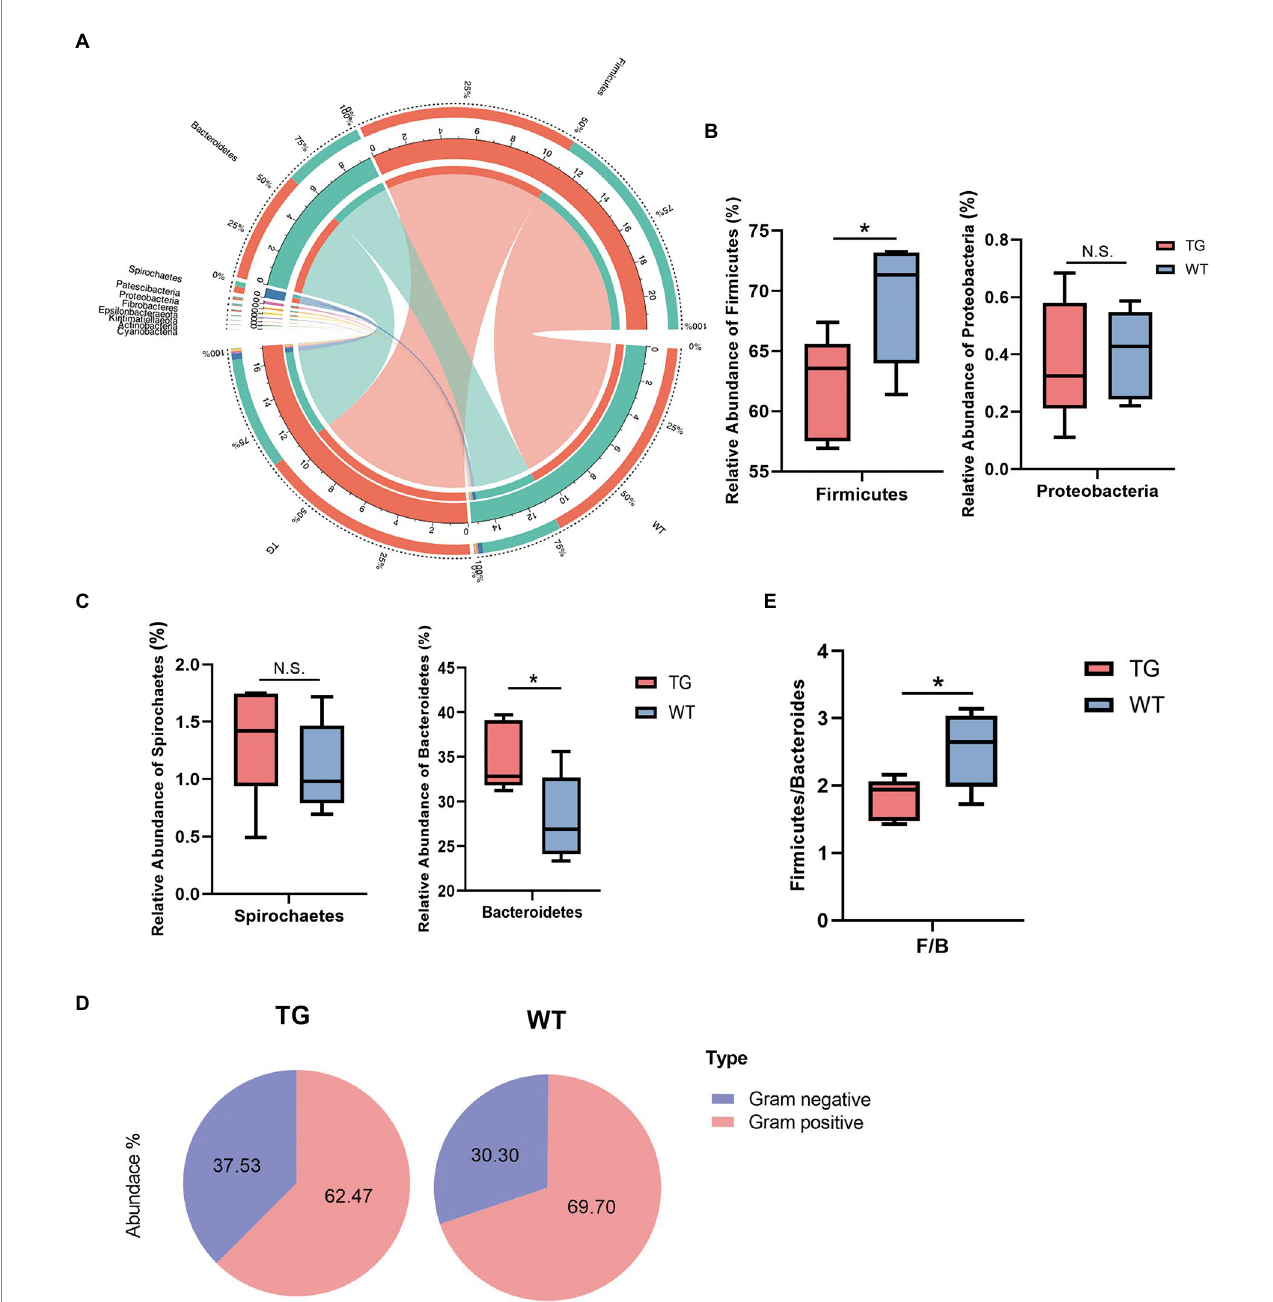
FIGURE 4 Microbiota composition of each group and changes at the phylum levels. (A) The correlations of microbiota with the samples in the TG group and WT group were analyzed by Circos. (B) Influence of TLR4 overexpression on sheep in the Firmicutes phylum and Proteobacteria phylum. The abundances of Firmicutes phylum differed significantly between TG and WT. (C) The relative abundance of the Spirochaetes phylum and Bacteroidetes phylum. (D) The pie charts depict the average abundance of Gram-positive and Gram-negative in two groups. (E) The Firmicutes/Bacteroidetes ratio (F/B). N = 5 each group; * p < 0.05 compared with WT